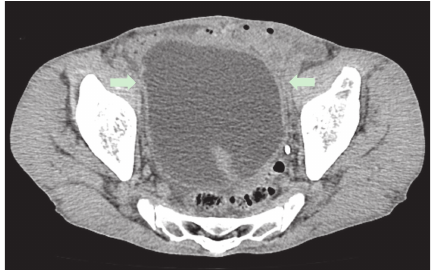
Figure 4: Compression of the bilateral common iliac veins (arrows) by the distended bladder on plain abdominal